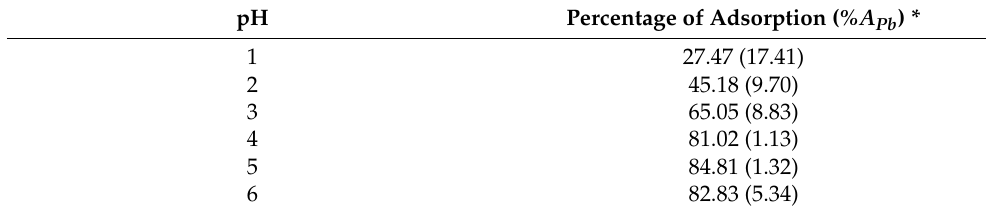
Table 2. Effect of amount of ZnO nanoparticles’ pH